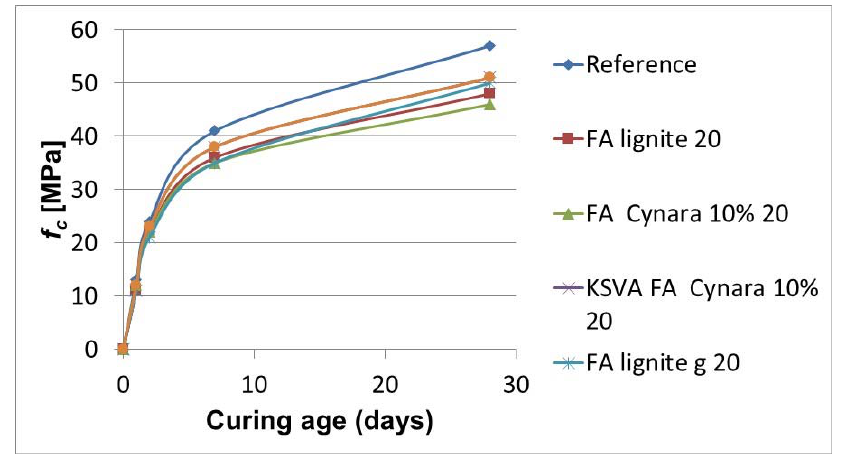
Figure 20. Comparison of strength development for 10% thermal share of Cynara fly ash from KSVA with industrial fly ashes to include 10% thermal share of Cynara , with 20% cement substitution; g = ground fly ash, FA = fly ash.